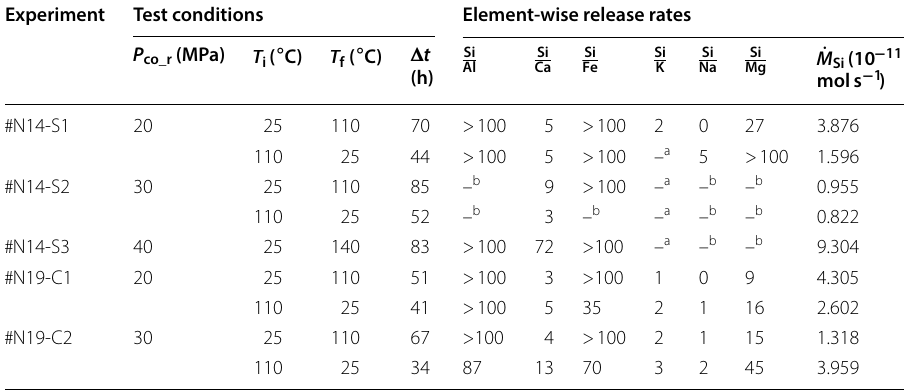
Table 6 Element-wise release